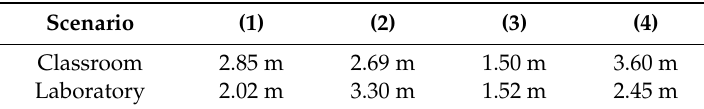
Table 1. The distances in the classroom and the laboratory.